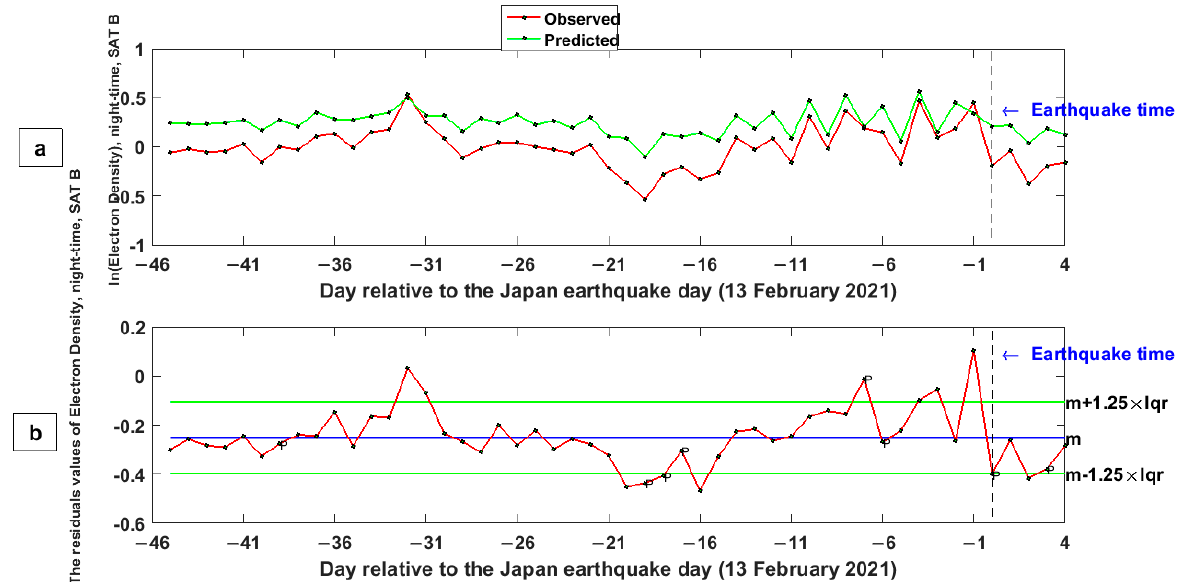
Figure 5. ( a ) Variations of the observed (red curve) and the predicted (green curve) night-time natural logarithm of the electron density measured by Swarm B and obtained by the LSTM method during testing days. ( b ) Variations of the differences between the observed and the predicted values of electron density obtained by the LSTM method during testing days. The green horizontal lines indicate the upper and lower bounds as m ± 1.25 × Iqr . The blue horizontal line indicates the median value ( M ). In both figures, the x -axis represents the day relative to the earthquake day. The geomagnetically “perturbed” days are highlighted by a